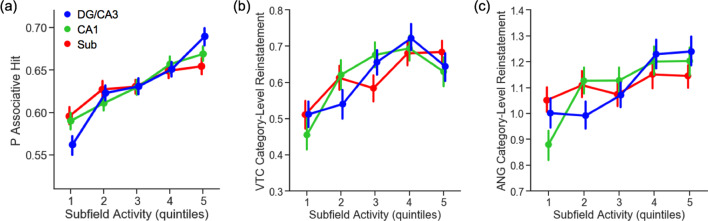
Hippocampal subfield activity during associative retrieval.(a) Retrieval activity in DG/CA3 (χ2(1) = 37.03, p < 10−9), CA1 (χ2(1) = 23.16, p < 10−6), and Sub (χ2(1) = 15.29, p < 10−5) is a significant predictor of associative retrieval success. This relationship varies in strength across subfields (χ2(1) = 12.99, p < 0.001), with DG/CA3 activity being a significantly stronger predictor than CA1 (z = 2.31, p < 0.05) or Sub (z = 3.55, p < 0.001), whereas CA1 and Sub do not significantly differ (z = 1.24, p > 0.21). (b) Category-level reinstatement strength in VTC is related to activity in all subfields (DG/CA3: χ2(1) = 12.25, p < 0.001; CA1: χ2(1) = 15.40, p < 10−5; Sub: χ2(1) = 13.38, p < 0.001; interaction: p = 0.703). Subfield activity is no longer a significant predictor of VTC category-level reinstatement when considering associative hit trials only (DG/CA3: p = 0.748; CA1: p = 0.175; Sub: p = 0.504). (c) Category-level reinstatement strength in ANG is related to activity in DG/CA3 (χ2(1) = 7.89, p = 0.005) and CA1 (χ2(1) = 10.49, p = 0.001), but not Sub (p = 0.458); DG/CA3 and CA1 effects do not differ (p = 0.988). When considering associative hit trials, only DG/CA3 remains marginally significant (χ2(1) = 2.86, p = 0.091; CA1: p = 0.437; Sub: p = 0.572). For visualization, data for each participant are binned into quintiles based on hippocampal subfield activity. Statistics were conducted on trial-wise data, z-scored within participant. Error bars represent standard error of the mean. VTC = ventral temporal cortex; ANG = angular gyrus; DG = Dentate Gyrus; Sub = Subiculum.